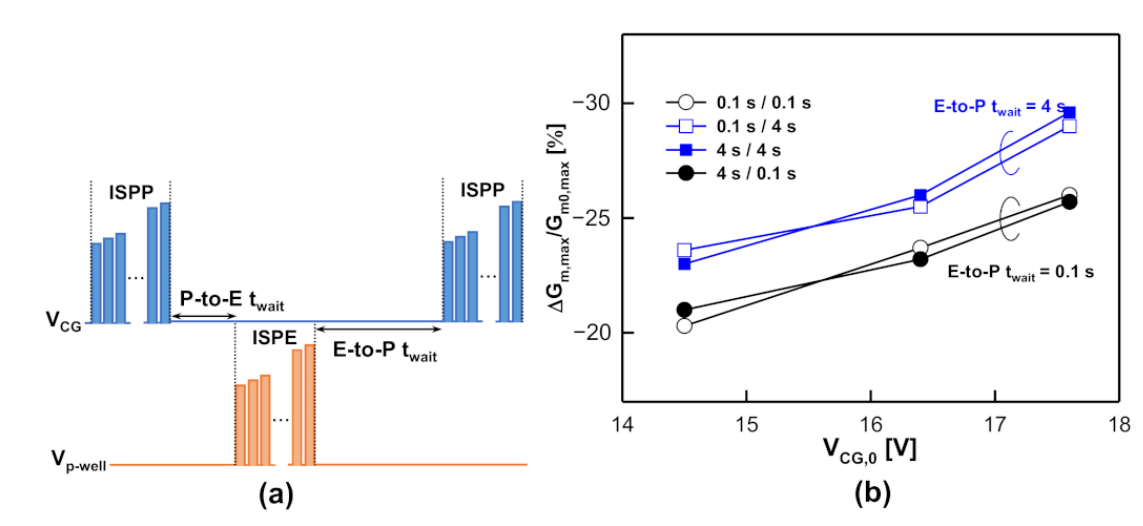
Figure 18. ( a ) Different P-to-E and E-to-P values of t wait are introduced between P/E cycles. ( b ) Dependence of normalized ∆ G m , max on P-to-E and E-to-P values of t wait after 30 k cycles. Reprinted from [55].